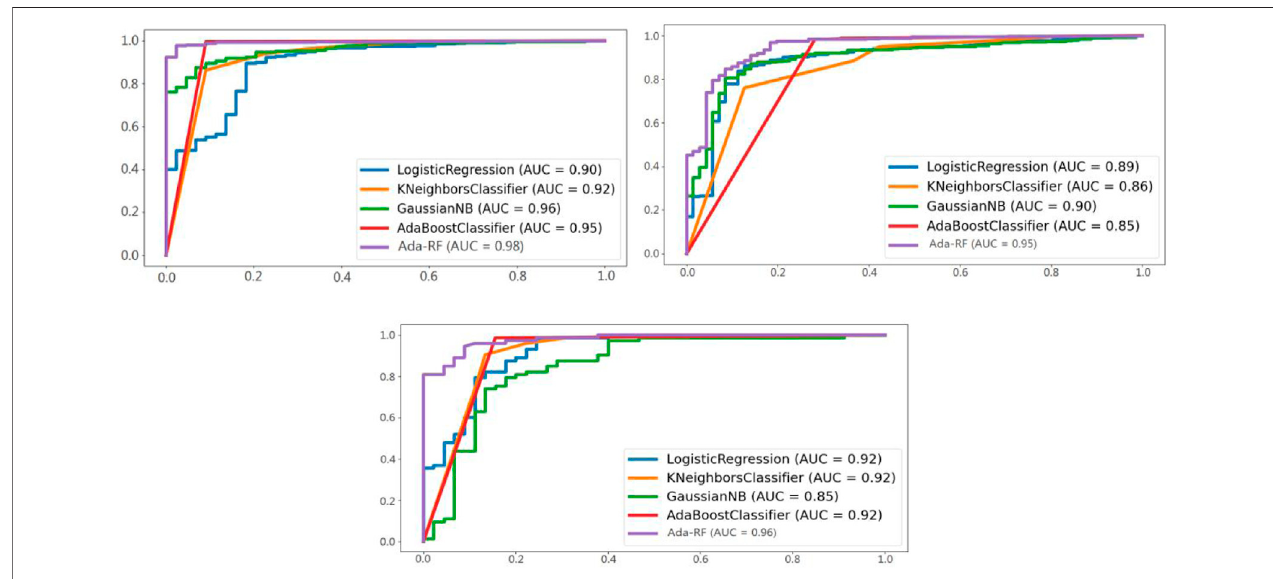
FIGURE 3 | ROC curve areas of different models in the three groups of classi fi cation.